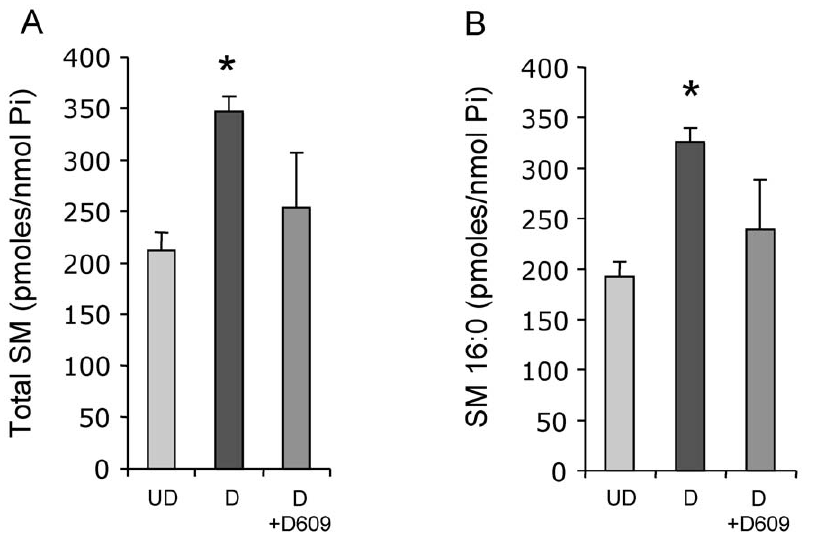
Figure 7. Mass spectrometry analysis of sphingomyelin in HL-60. ( A ) Total levels of SM in HL-60 undifferentiated (UD), differentiated (D) and HL-60 D treated with D609, as measured by LC-MS and normalized by nanomole of lipid inorganic phosphate (Pi). * P , 0.05, compared to UD cells. ( B ) Specific lipid species for SM (16:0) in HL-60 undifferentiated (UD), differentiated (D) and HL-60 D treated with D609, as measured by LC-MS and normalized by Pi. * P , 0.05, compared to UD cells.